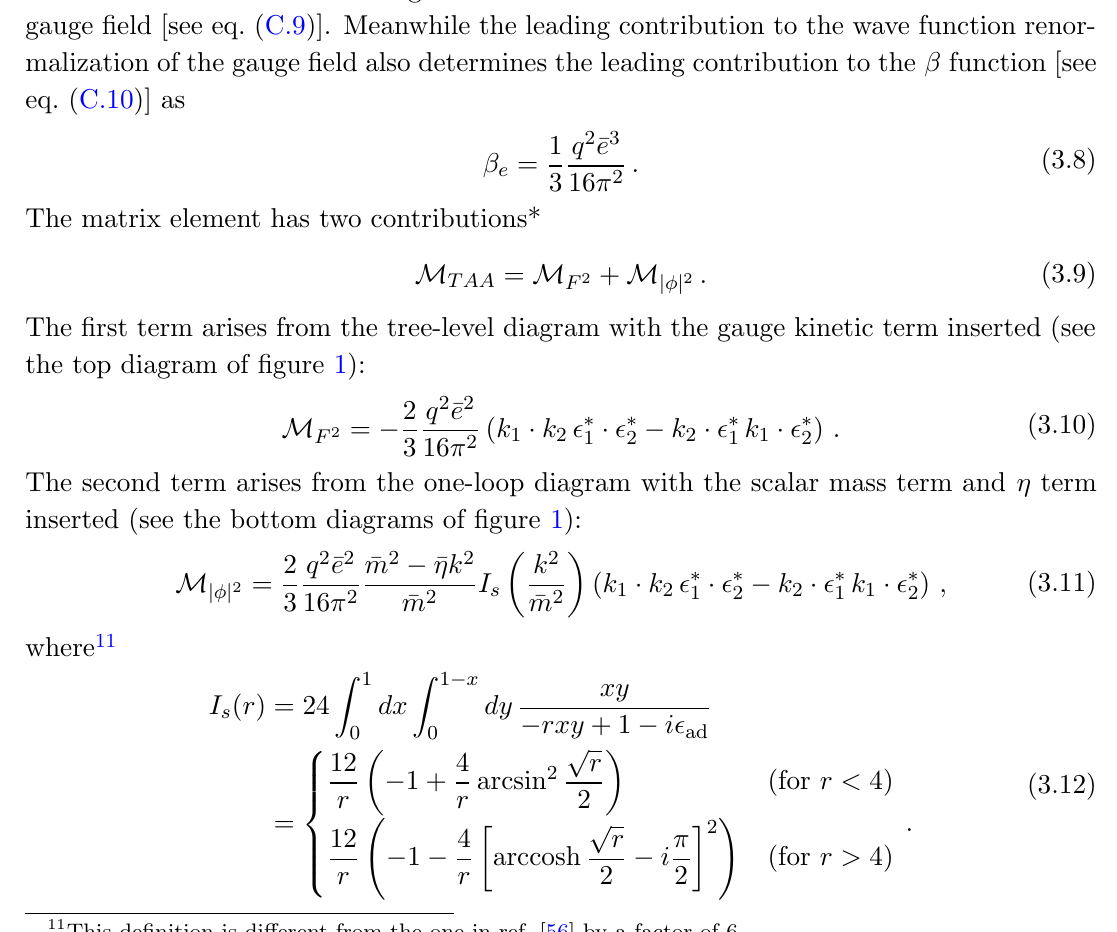
Figure 1 . The leading contributions to M TAA , i.e., T (cid:22) - (cid:22) A (cid:21) - (cid:22) A (cid:20) correlation function ( (cid:27) decay into (cid:22) two gauge bosons). [Top] M : the gauge kinetic term in eq. (3.7) is inserted. [Bottom] M F 2 the scalar mass term and (cid:17) term in eq. (3.7) is inserted. There is the other contribution from the left diagram with the external gauge bosons